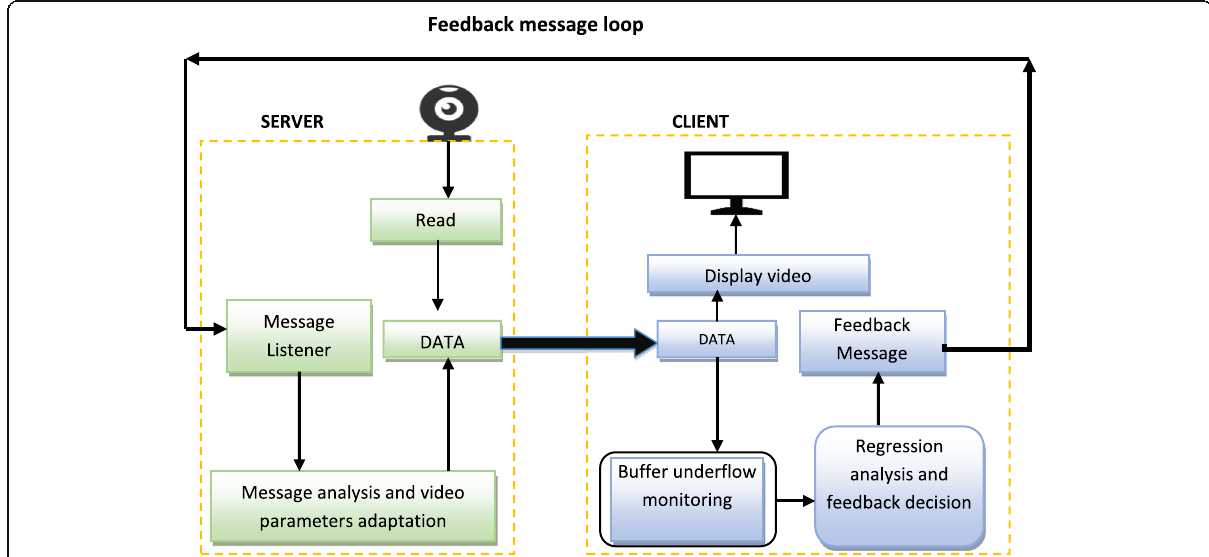
Fig. 2 Adaptive video streaming. The client-server architecture works in a loop to adaptively adjust the parameter of streamed video with an aim to achieve maximum obtainable